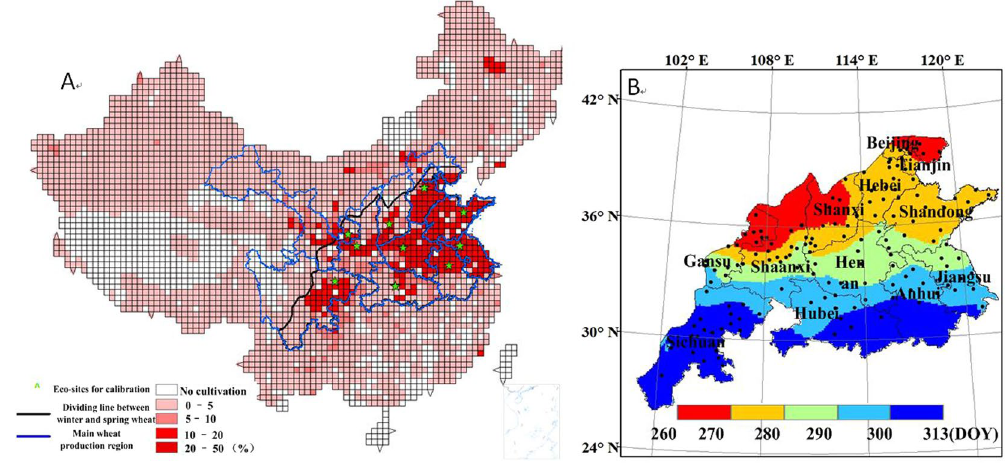
Figure 1. ( A ) Distribution map 9 of the wheat planting area proportion, main wheat growing region and dividing line between winter and spring wheat (black line); ( B ) Julian day of average sowing date from 1998 to 2003 (This figure was created by ArcGIS 9.3,